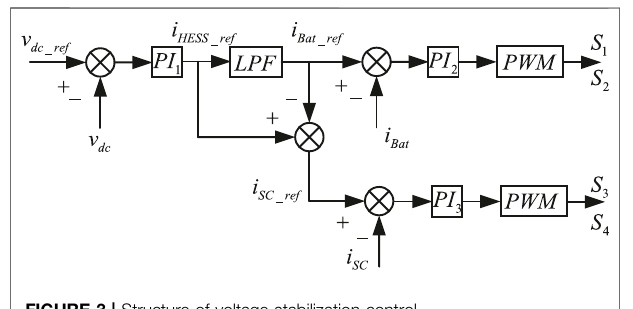
FIGURE 3 | Structure of voltage stabilization